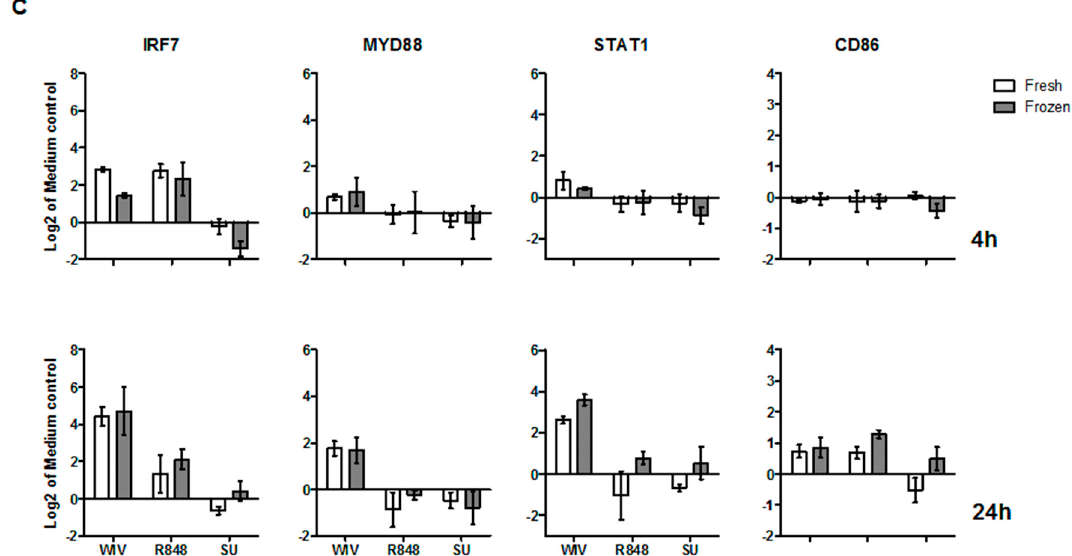
Figure 6. Differences in gene expression induced by WIV and SU are consistent in Mo-DCs derived from fresh and frozen/thawed PBMCs. ( A , B ) WIV––(blue lines) and SU––(red-lines) induced changes in gene expression in Mo-DCs derived from fresh (dark colors) and frozen/thawed (light colors) PBMCs from matching donors. Cells were stimulated for 4 h ( A ) and 24 h ( B ). Results are expressed as mean log2 fold change compared to mock-stimulated cells ( n = 4); ( C ) Quantitative representation of the gene expression data. Bars represent the mean log2 fold change in gene expression as compared to the medium control of four different donors +/ − standard deviation.